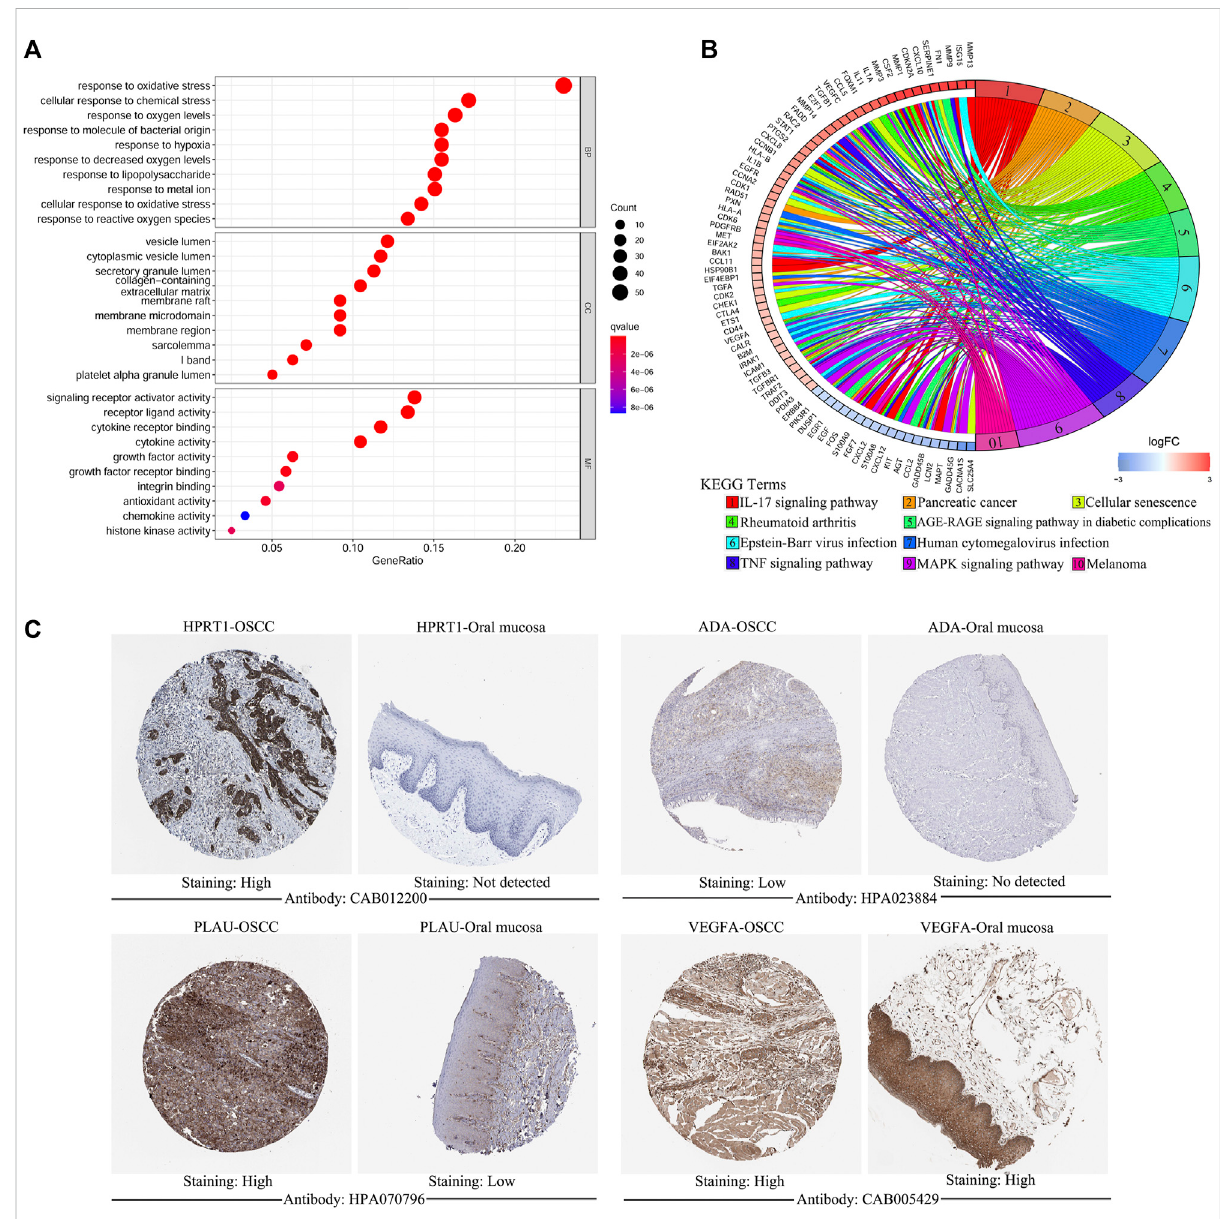
FIGURE 1 The functional enrichment analysis of oxidative stress-related differentially expressed OSGs between OSCC samples and matched adjacent normaltissuesandtheimmunohistochemistryofsignaturegenesfromtheHPAdatabase. (A) GOtermenrichmentanalysisofdifferentiallyexpressed OSGs. (B) KEGG pathway enrichment analysis of differentially expressed OSGs. (C) Representative images showing the expression of HPRT1, ADA, PLAU, and VEGFA in OSCC tissues vs. normal oral cavity mucosal tissues. OSGs, Oxidative stress-related genes, OSCC, Oral squamous